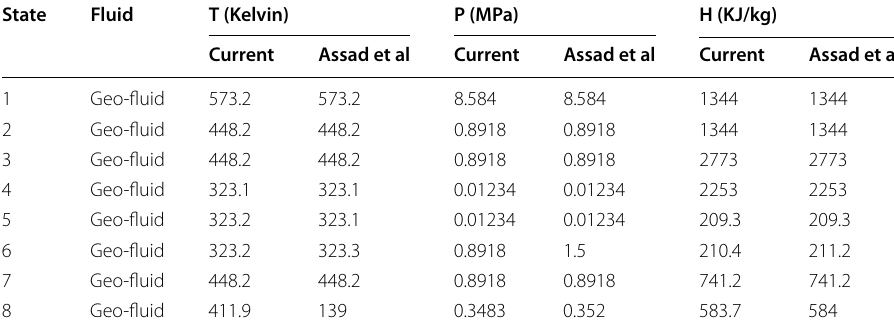
Table 4 Comparison of current simulation results with Assad et al. results (Assad et al.